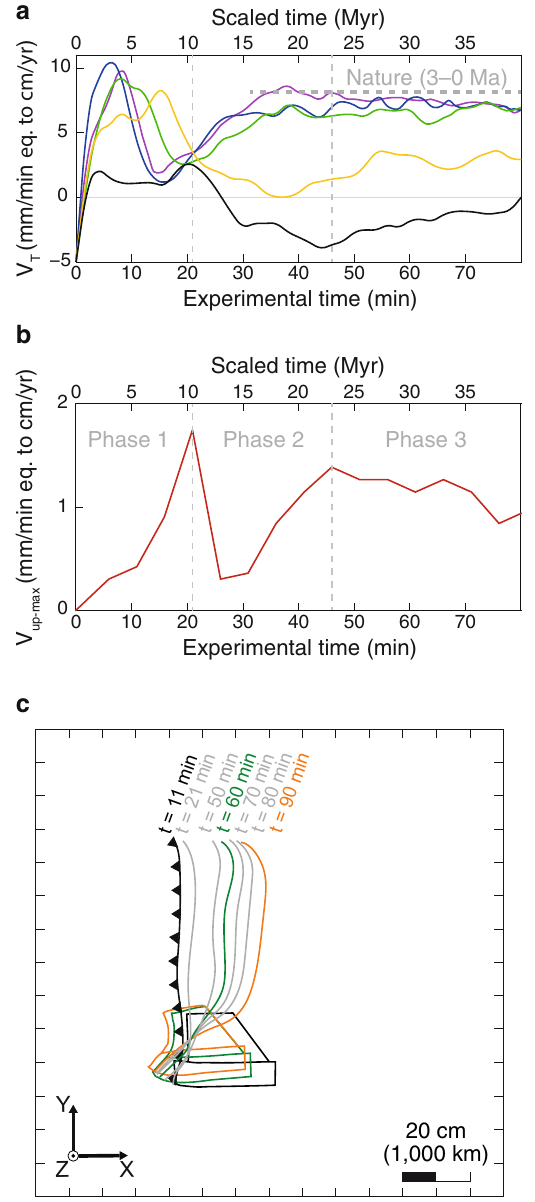
Figure 4. Predicted evolution of trench kinematics and SIMU magnitude. ( a ) Evolution of trench retreat velocity in time for five locations along the trench, reported on Fig. 3d. ( b ) Evolution of SIMU maximum velocity in time. ( c ) Line drawing showing the evolution of asymmetric trench